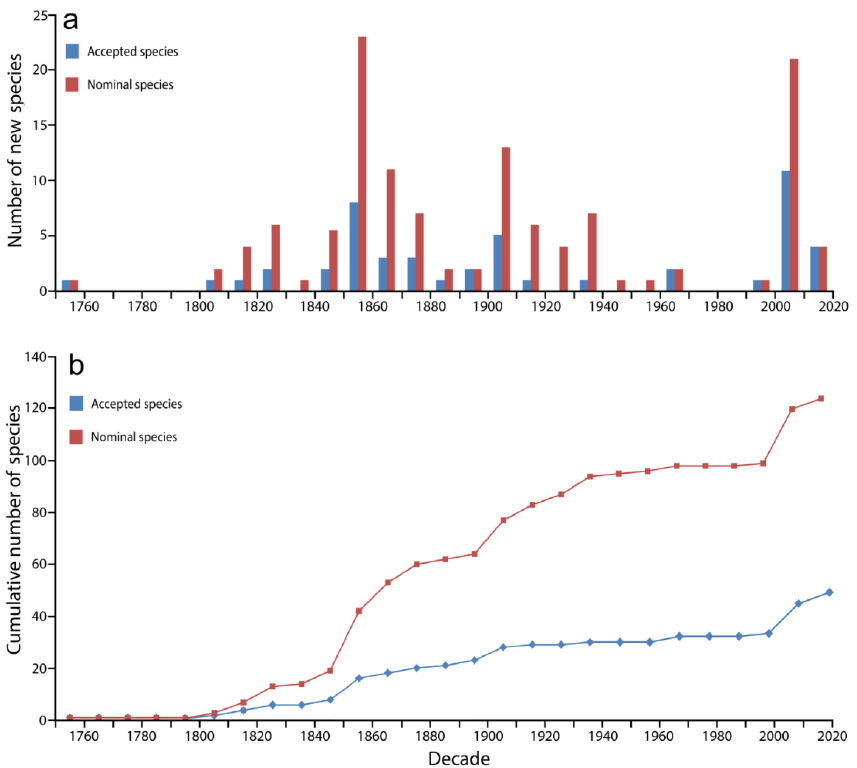
Figure 1. Description of new Hippocampus species, accepted and nominal (1758–2020): numbers per decade ( a ) and cumulative ( b ). Original data from FishBase and WoRMS [66,67]. Accepted species are listed in Table 1.